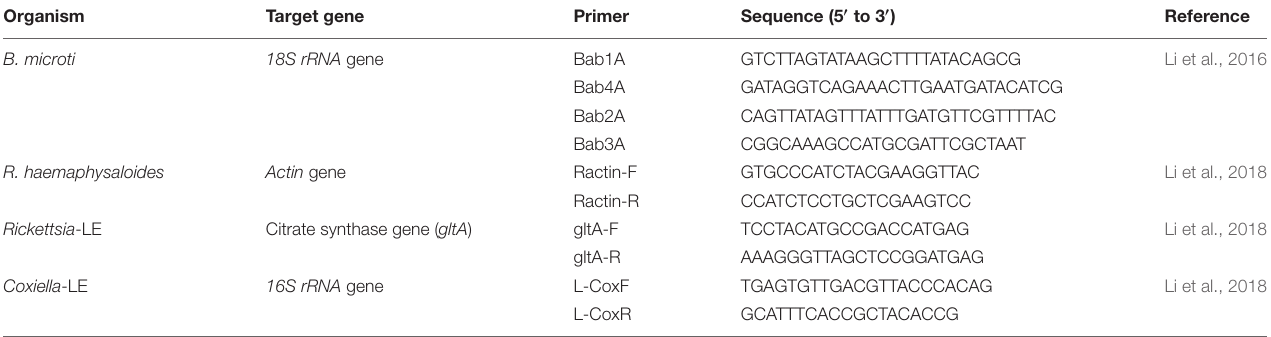
TABLE 1 | Primers for PCR and qPCR